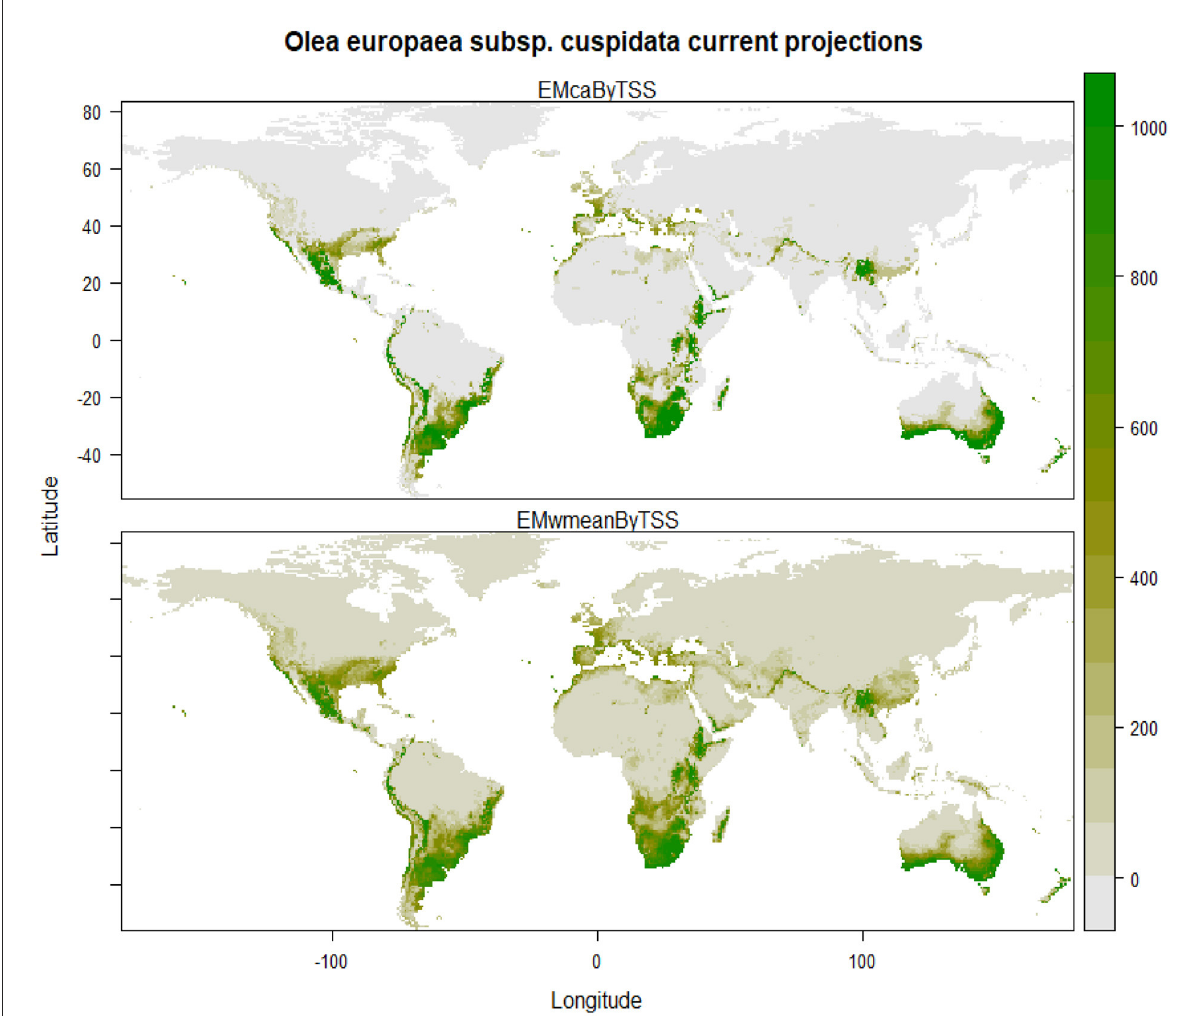
FIGURE2 Plot showing the geographic projections using the committee average (above) and weighted mean (below) ensemble models for Olea europaea subsp. cuspidata under current climatic